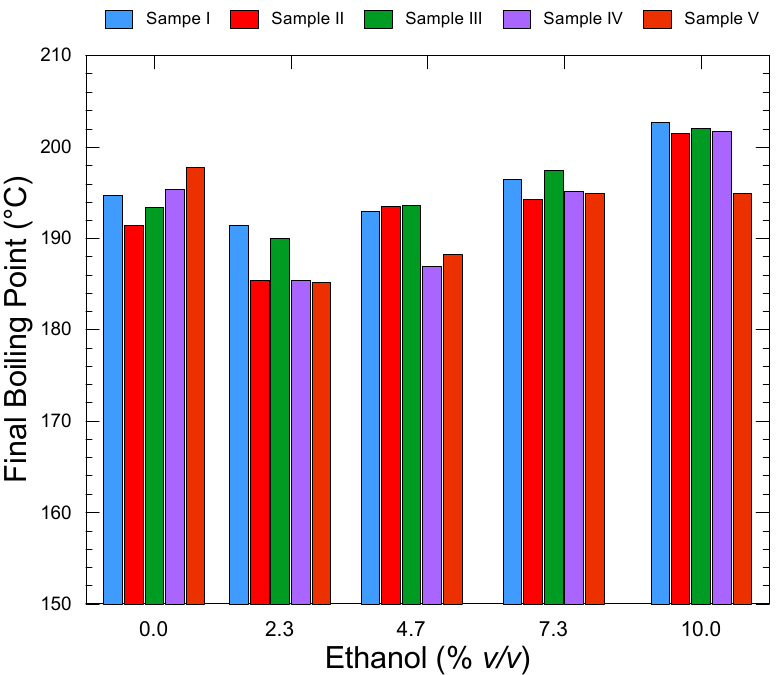
Figure 11. Final boiling point (FBP) values for all blends against bio-ethanol content.